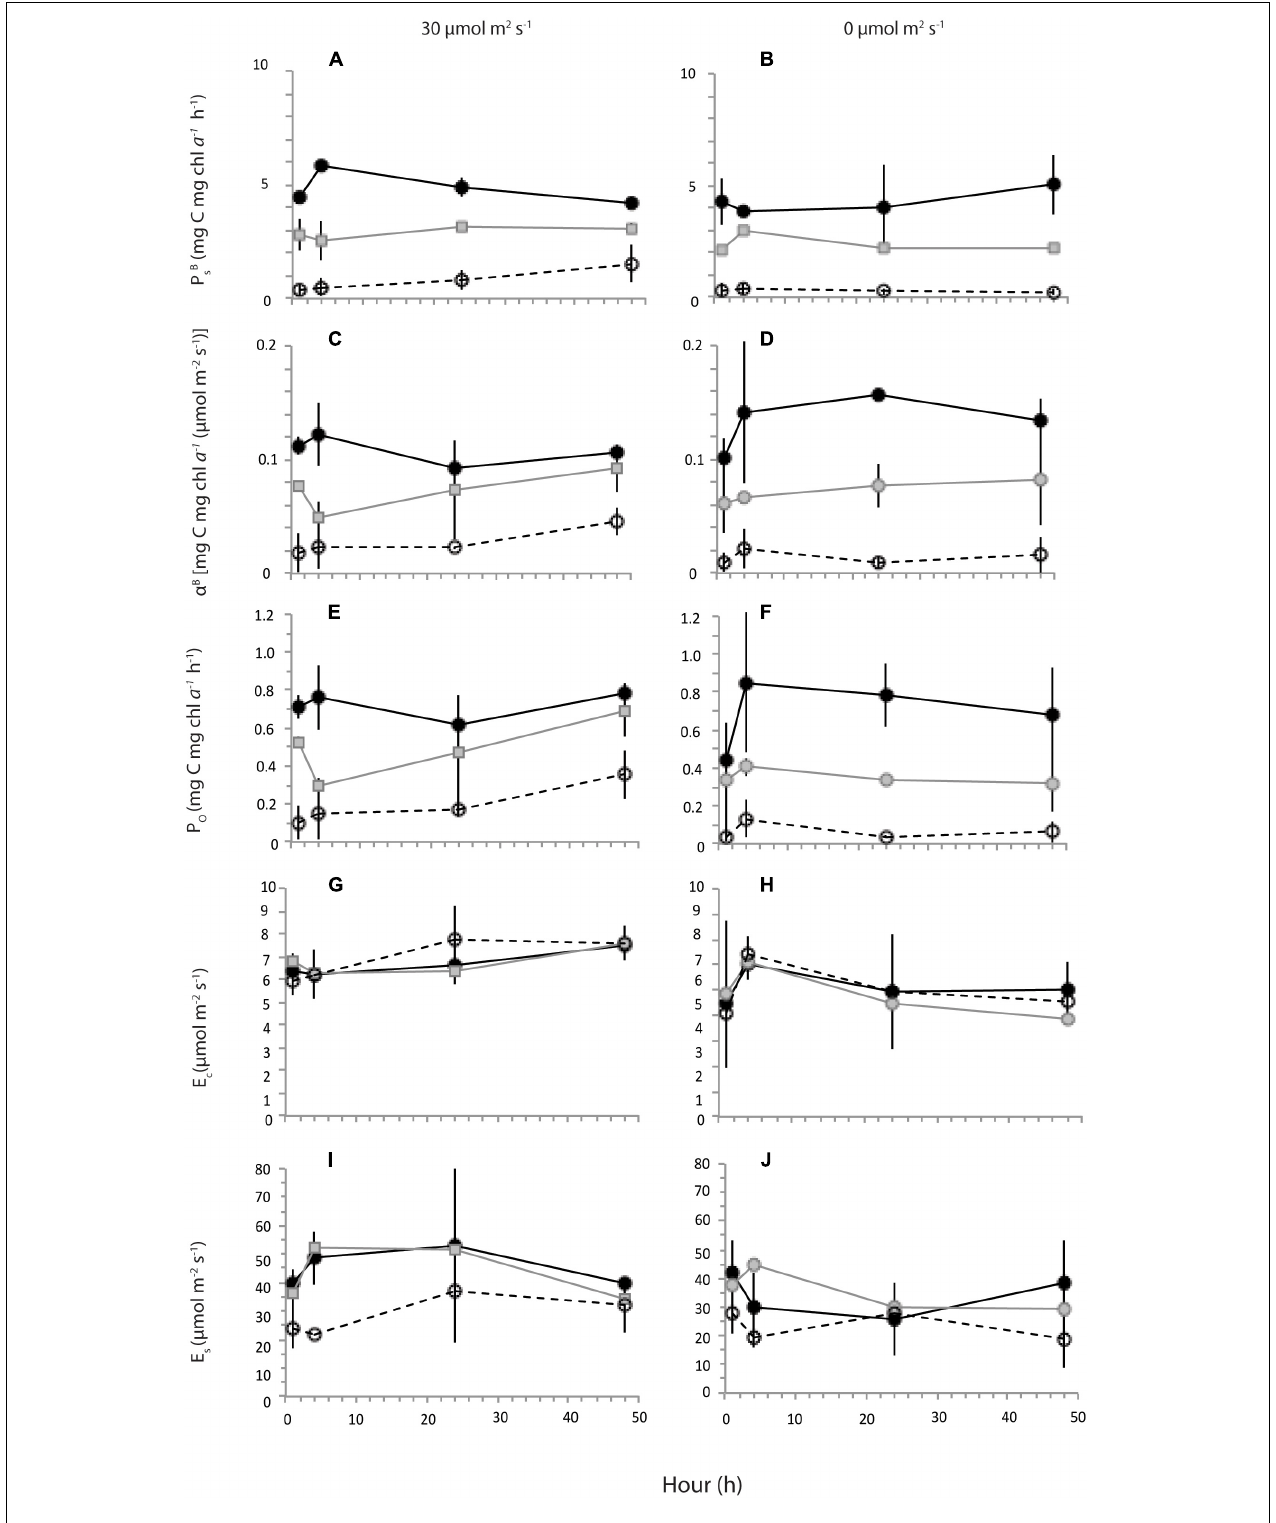
FIGURE 5 | Average ( n = 2) photosynthetic parameters (see text for definitions) with standard deviation of algae grown in treatments of 30 (black), 20 (gray) and 12 (white) salinities for time intervals 1, 4, 24, and 48 h under 30 µ mol m − 2 s − 1 (A,C,E,G,I) or in the dark (B,D,F,H,J) .